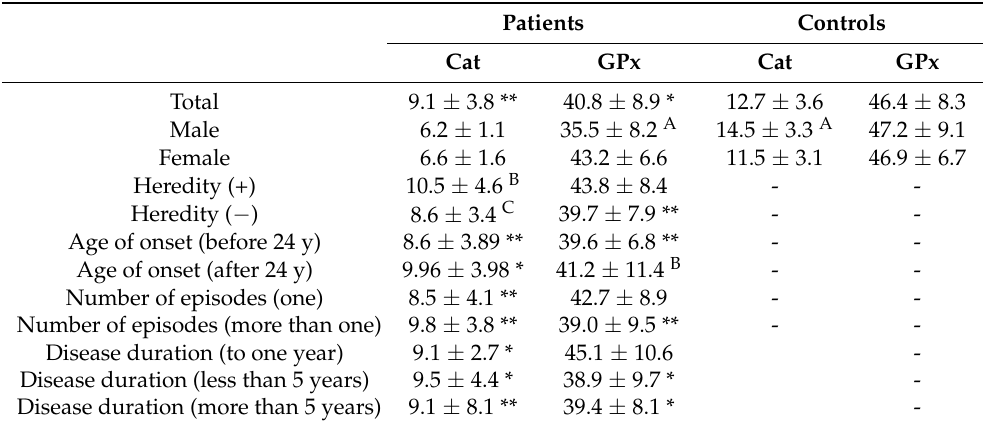
Table 2. Erythrocyte catalase and GPx activities in schizophrenia patients in relation to demographic and clinical characteristics.